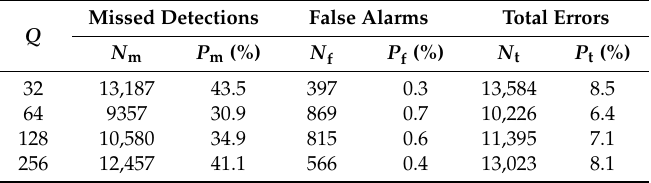
Table 2. Accuracy of CD results for different thresholds of data set 1.